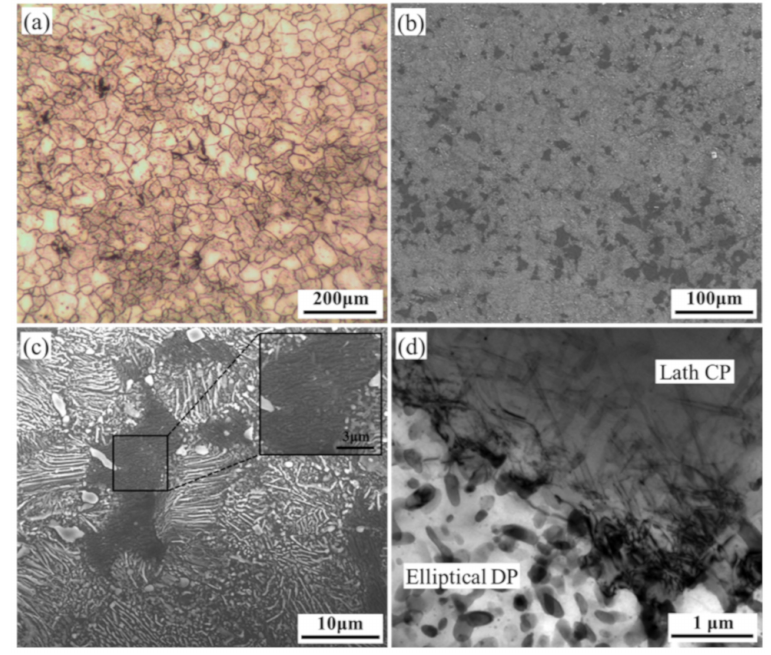
Figure 1. Microstructure of ( a ) hot-ring-rolled (HRRed) and ( b – d ) T5 specimens.